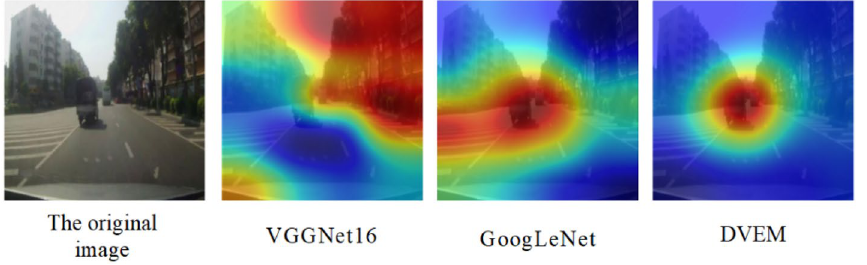
Figure 11. VGGNet16, GoogLeNet, DVEM imaging